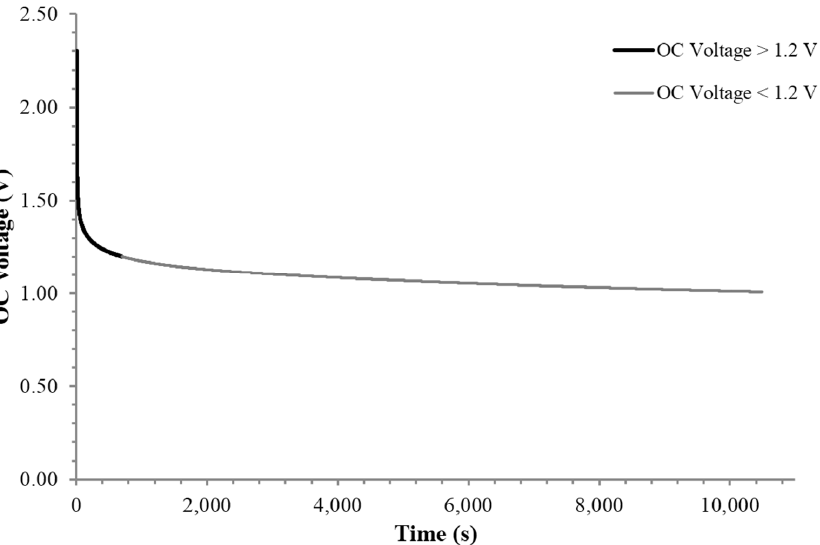
Figure 9. Open circuit voltage. There is clearly a dramatic change in internal resistance at approximately 1.2 V, the voltage of water decomposition. 1.2 V, the voltage of water